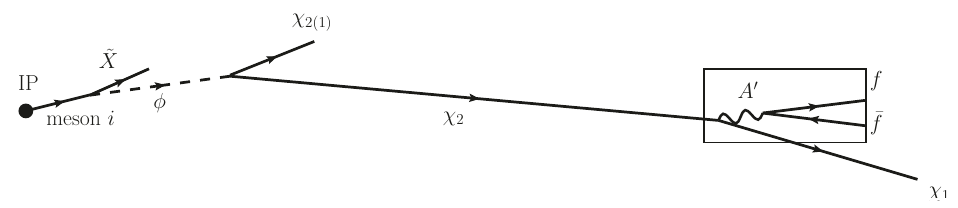
Figure 2 . Sketch of the production of χ 2 from the decay of the scalar boson, and the subsequent decay into χ and f - ¯ f pair. IP denotes the Interaction Point at the ATLAS 1